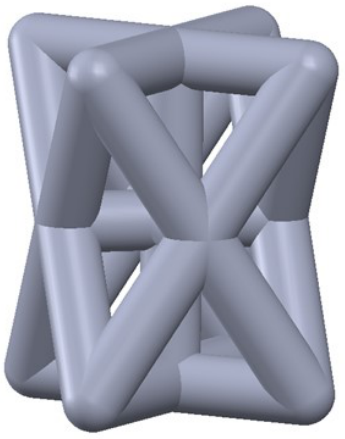
Figure 10. Optimized Model Illustration.